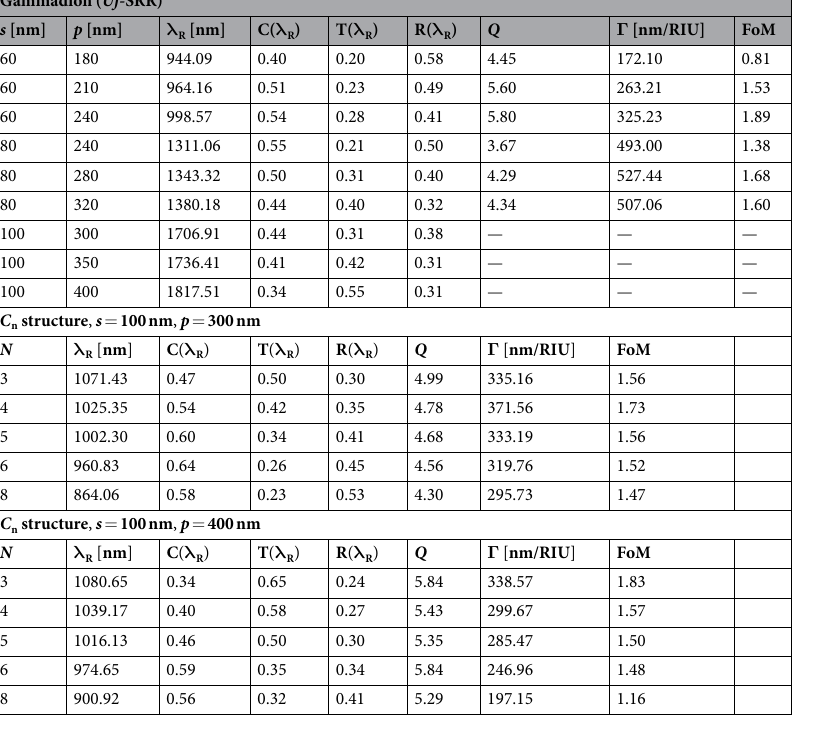
Table 2. Sensing parameters of Uf-SRR and C n